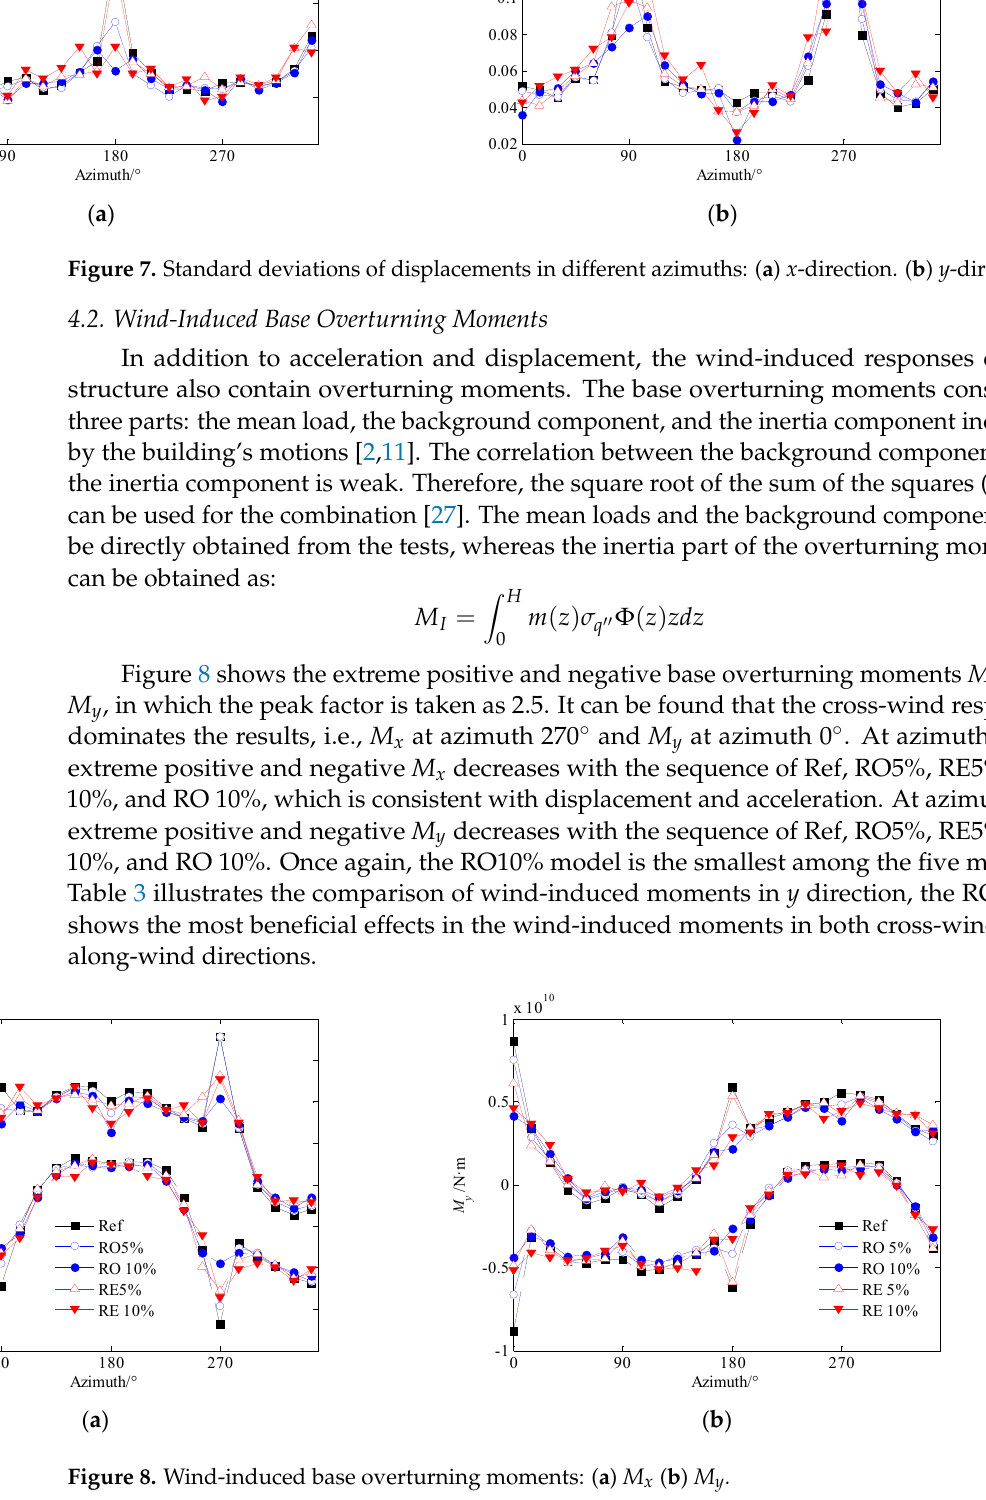
Figure 6. Standard deviations of accelerations in different azimuths: ( a ) x -direction. ( b ) y -direction.